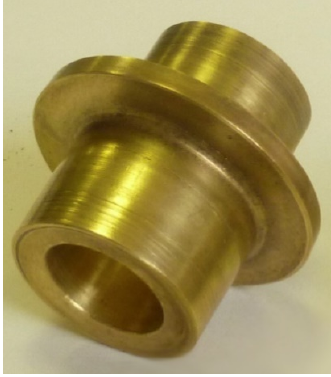
Figure 8. The finished part.